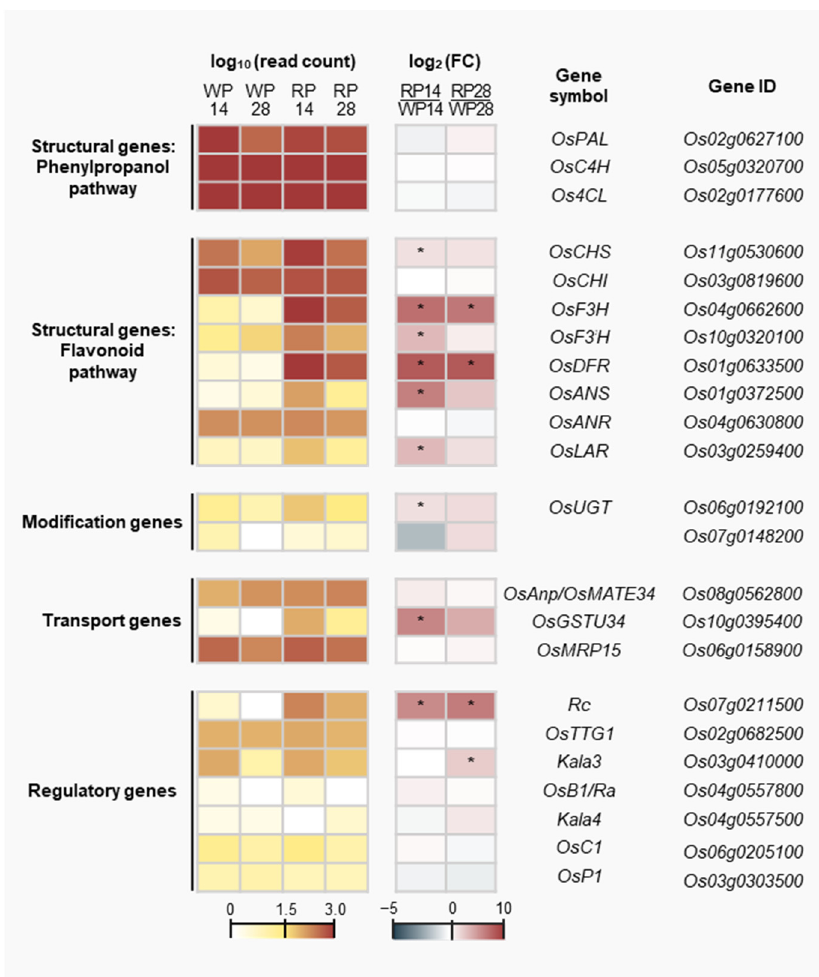
Figure 4. Heatmap of selected PA biosynthesis-related genes in two different seed developmental stages. Asterisks indicate significant differences between the expression levels of red pericarp (RP) and white pericarp (WP) genes.